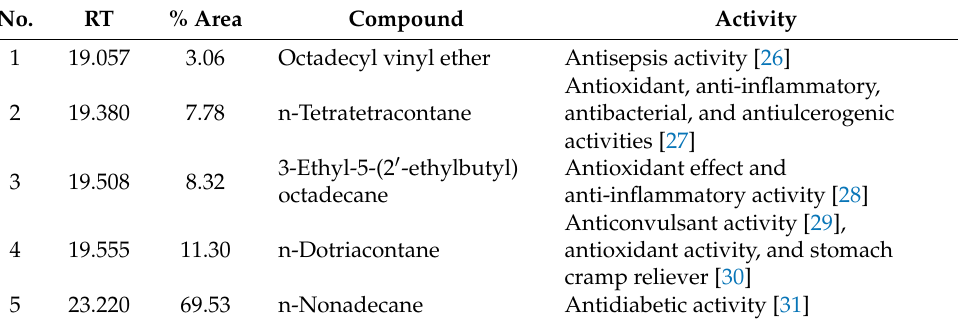
Table 4. Biological activity of compounds in ethyl acetate fraction of H. tuna